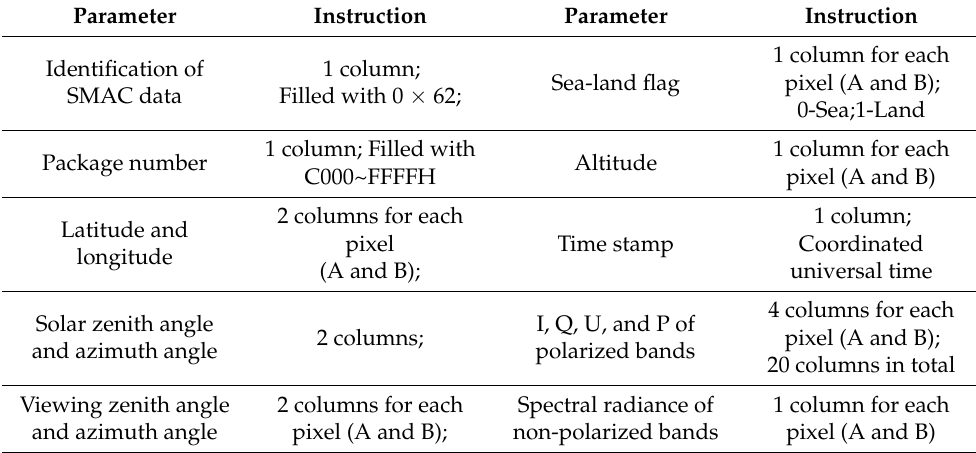
Table 3. Level-1 product of